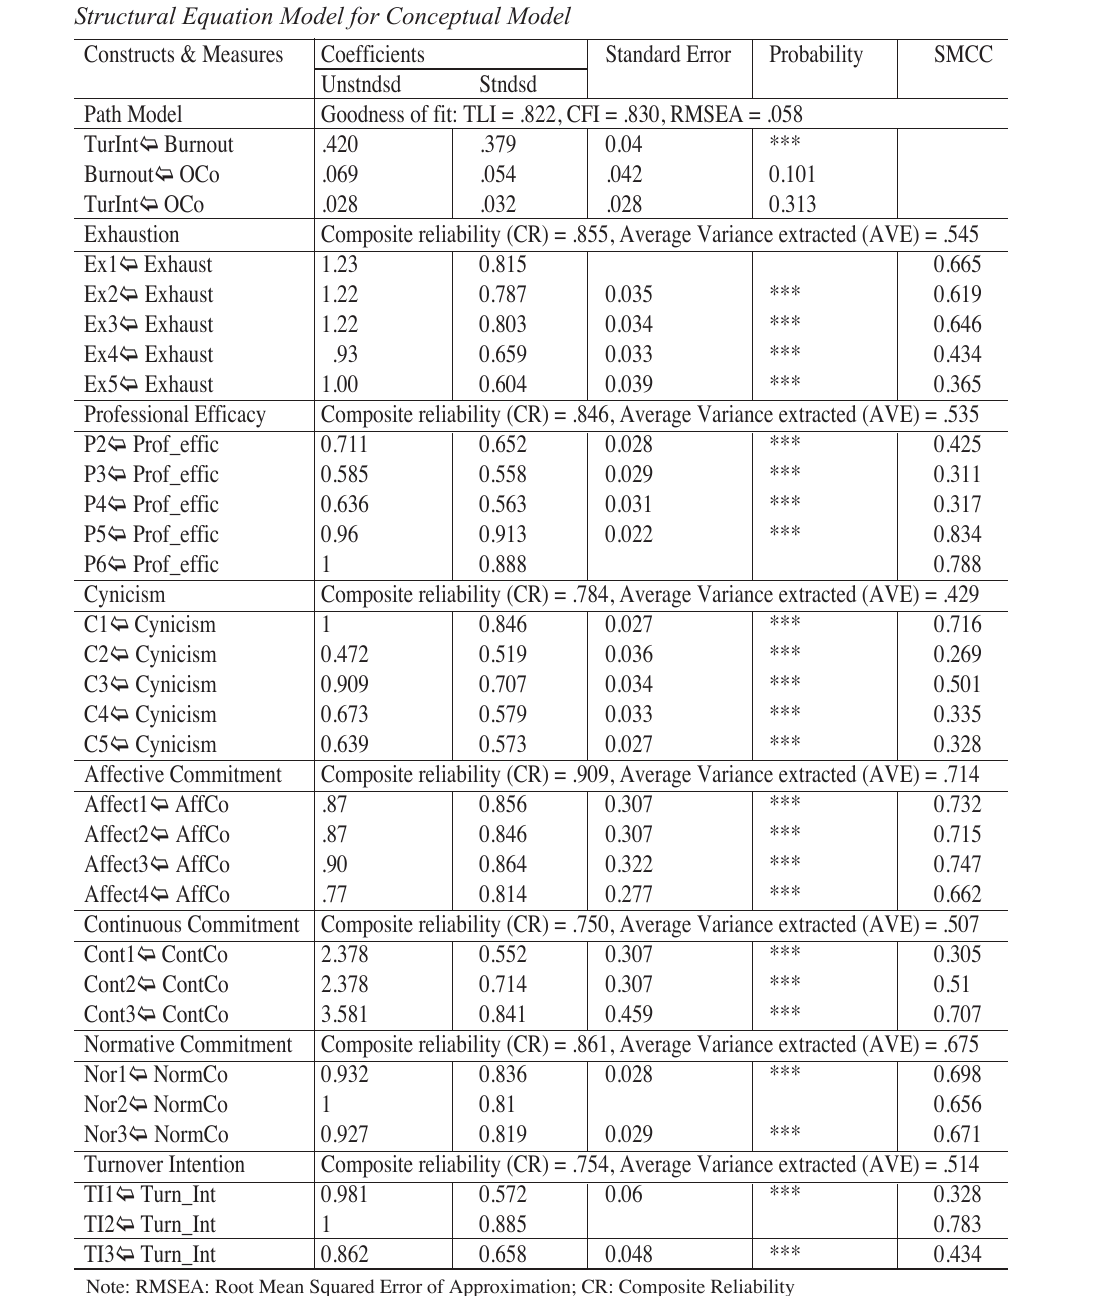
Table 4: Structural Equation Model for Conceptual